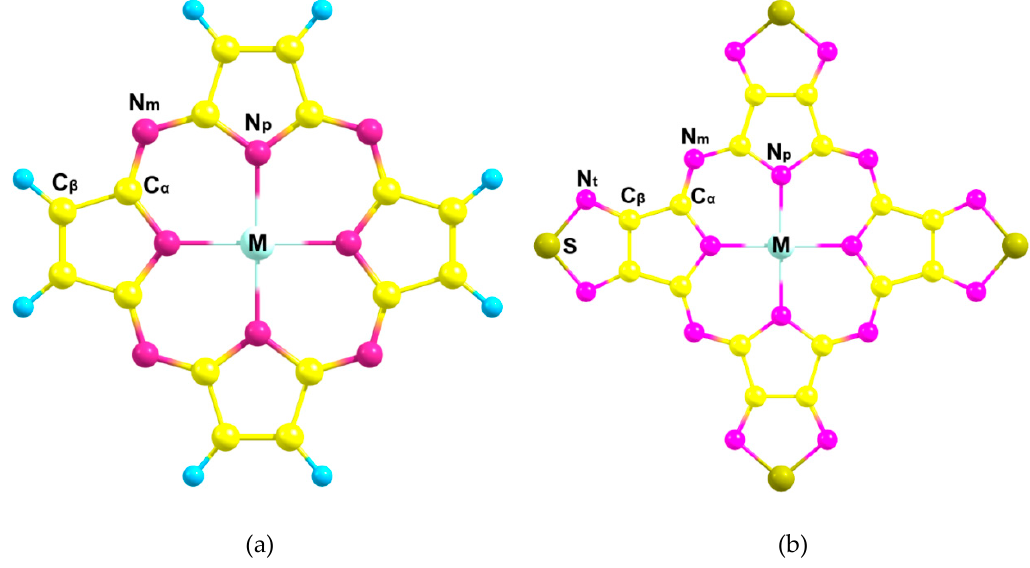
Figure 1. Molecular models of M-porphyzarine (MPz)( a ) and Figure1. Molecular models ofM-porphyzarine (MPz) ( a ) and M-tetrakis(1,2,5-thiadiazole)porphyzarine M-tetrakis(1,2,5-thiadiazole)porphyzarine (MTTDPz) ( b ) complexes with atom labeling (M = Ca, Zn). (MTTDPz) ( b ) complexes with atom labeling (M = Ca,